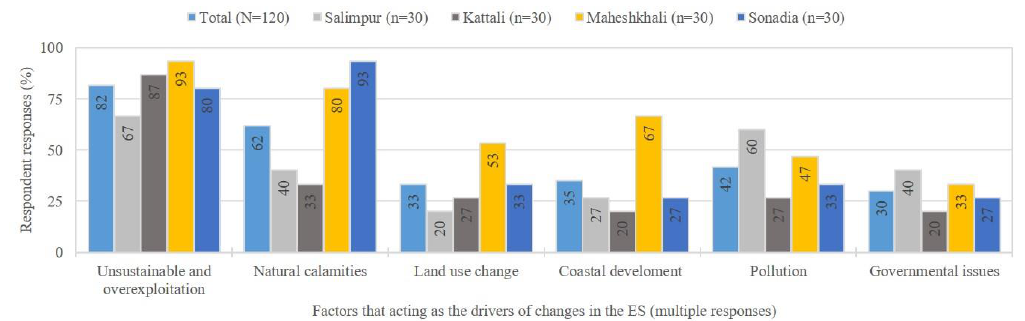
Figure 5. Community perception of factors or reasons that act as the drivers of changes in the ecosystem services along the south-eastern coast of Bangladesh.